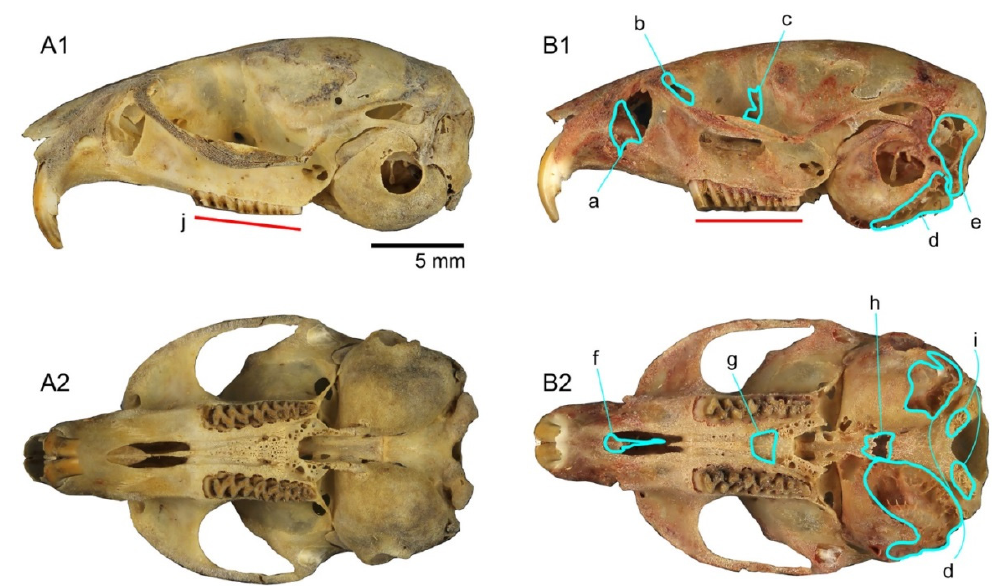
Figure 3. Skulls of 1-month-old M. h. ankaraensis ( A ) and M. hartingi from the Eastern Rhodopes ( B ) in lateral ( A1 , B1 ) and ventral ( A2 , B2 ) views. Abbreviations. a: the friable part of the maxilla (light blue outline; thin and friable bone lost through skeletonization by beetles); b: the friable part of the frontal and around the lacrimal bones; c: thin frontal bone with “fenestra”; d: a thin outer part of the tympanic bullae; e: a thin part of the occipital bone; f: a friable part of the vomer; g: a friable part of the palatine; h, i: friable parts of the occipital bone; j: the red line shows a continuous profile of the molar row. The scale bar is 5